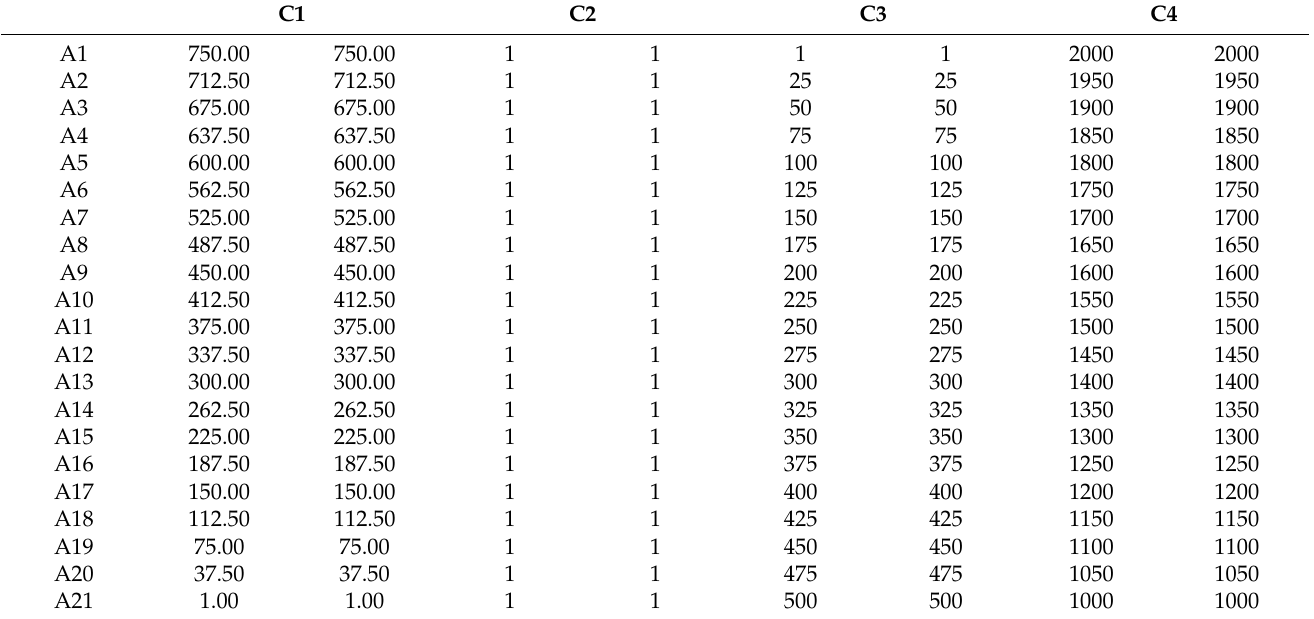
Table 5. Initial decision